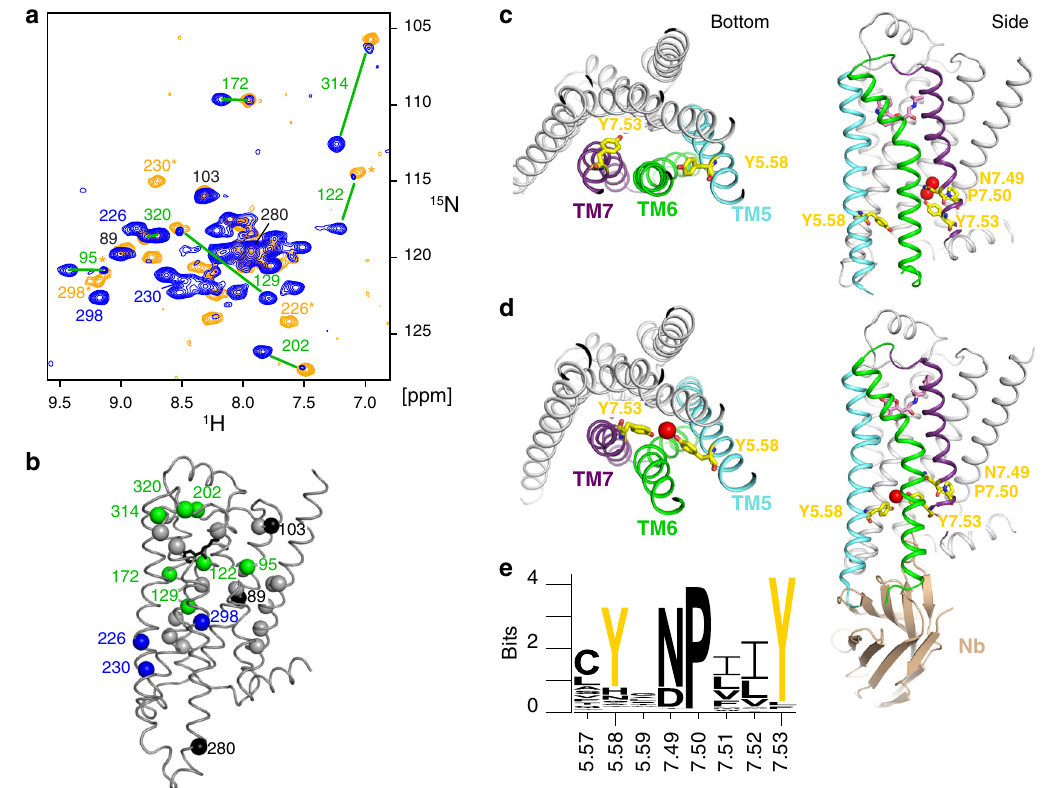
Fig. 7 Role of conserved tyrosines Y 5.58 and Y 7.53 in the activation of β 1 AR. a 1 H- 15 N TROSY spectra of 15 N-valine-labeled YY- β 1 AR in the binary complex with isoprenaline (blue) and in the ternary complex with isoprenaline and Nb80 (orange) at 21 T. Resonances are marked with assignment information. Green lines connect resonances corresponding to the major (preactive) and minor (active) conformation in the binary isoprenaline complex where the resonances of the minor conformation coincide with the ternary complex. Assignments marked by asterisks are tentative for the ternary complex. The minor V314 resonance of the YY- β 1 AR (cid:129) isoprenaline complex was only observed in a spectrum recorded at 14 T (Fig. 6). b Structure of β 1 AR in complex with isoprenaline (2Y03). Valines are shown as spheres color-coded according to the spectral observation in a . Green: minor conformation observed in the binary YY- β 1 AR (cid:129) isoprenaline complex, which coincides with the ternary YY- β 1 AR (cid:129) isoprenaline (cid:129) Nb80 complex. Blue: no second conformation observed in the binary complex. Black: no change between binary and ternary complex. Gray: no assignment available in the ternary complex. c , d Bottom and side view of tyrosines Y 5.58 and Y 7.53 in the structures of β 2 AR in a binary antagonist complex (2RH1, c ) and a ternary agonist (cid:129) Nb6B9 complex (4LDE, d ). Y 5.58 , N 7.49 , P 5.50 and Y 7.53 are depicted as sticks (CPK-yellow). Water molecules involved in H-bonds with Y 5.58 and Y 7.53 are shown as red spheres. Helices TM5, TM6, TM7 and Nb6B9 are indicated by different colors. e Conservation of Y 5.58 and the NPxxY 7.53 motif within all 1554 class A GPCR entries in the GPCRdb 59 . Source data are provided as a Source Data fi